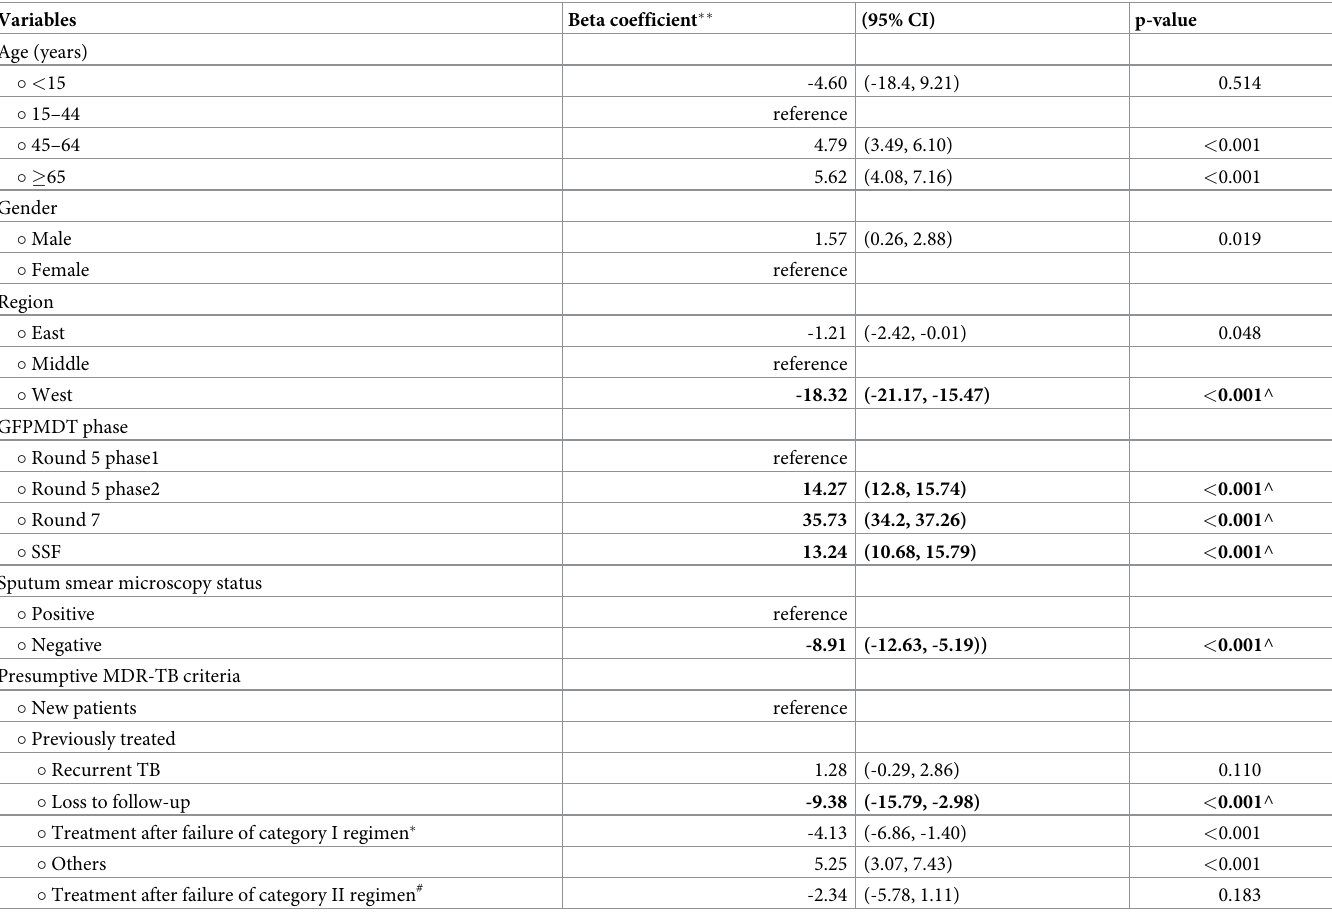
Table 5. Multivariable linear regression for factors associated with diagnosis delay (between eligibility for DST to DST) among patients with presumptive MDR-TB that underwent DST under GFPMDT project in China, October 2006-June 2013 [N = 68452].